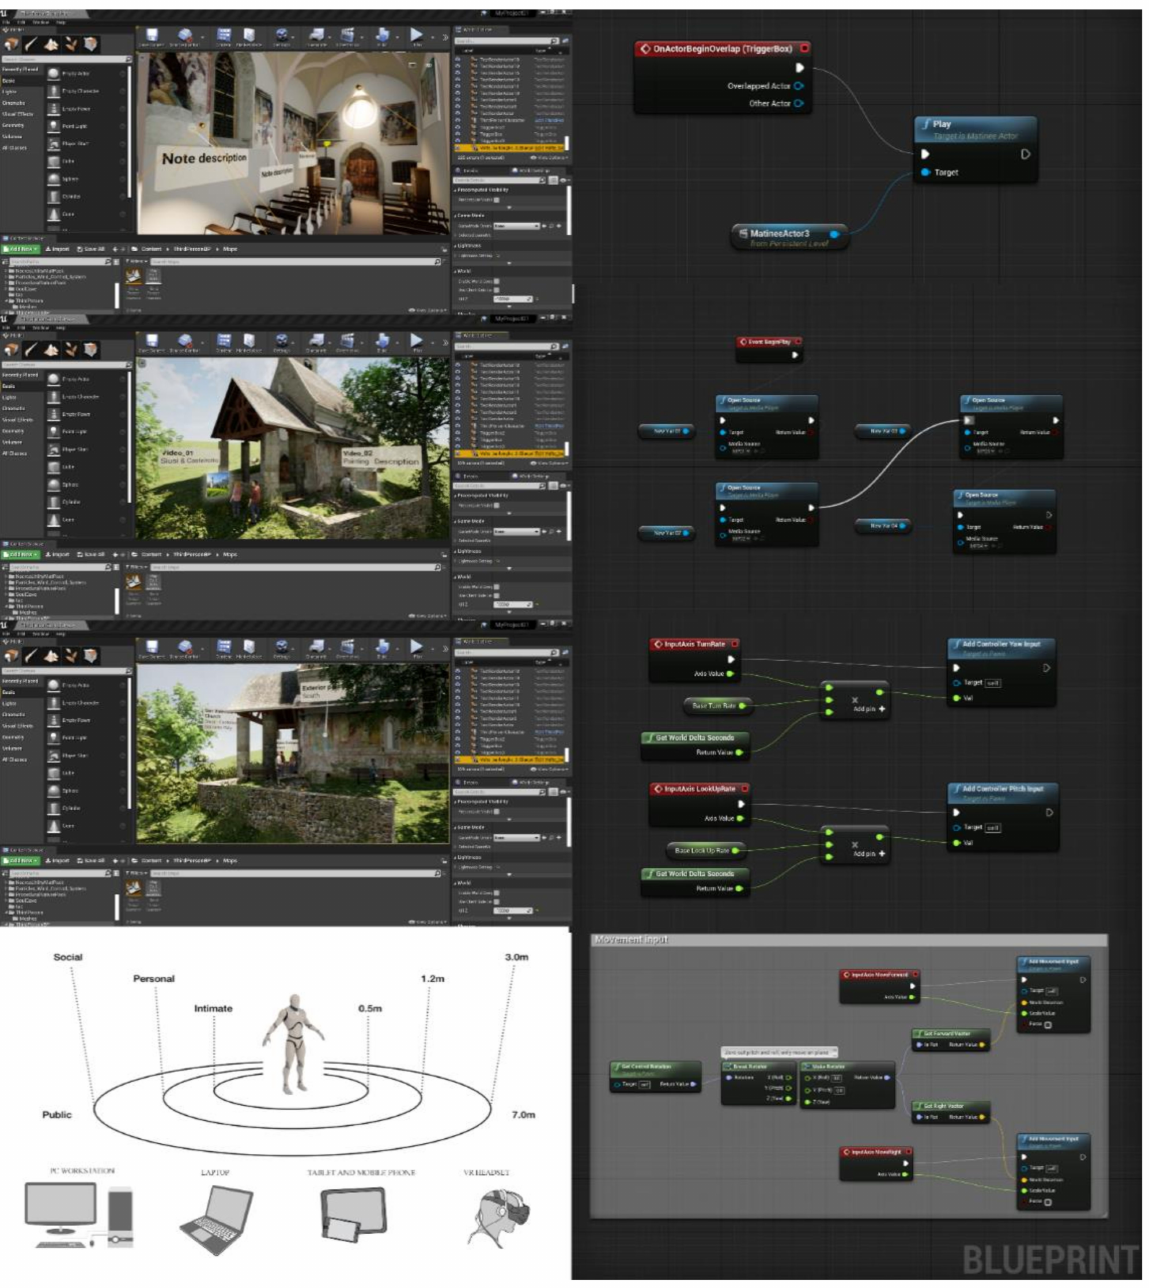
Figure 11. The main Visual Programming Language (VPL) in Unreal Engine implemented and used for the development of the VR app of the research case